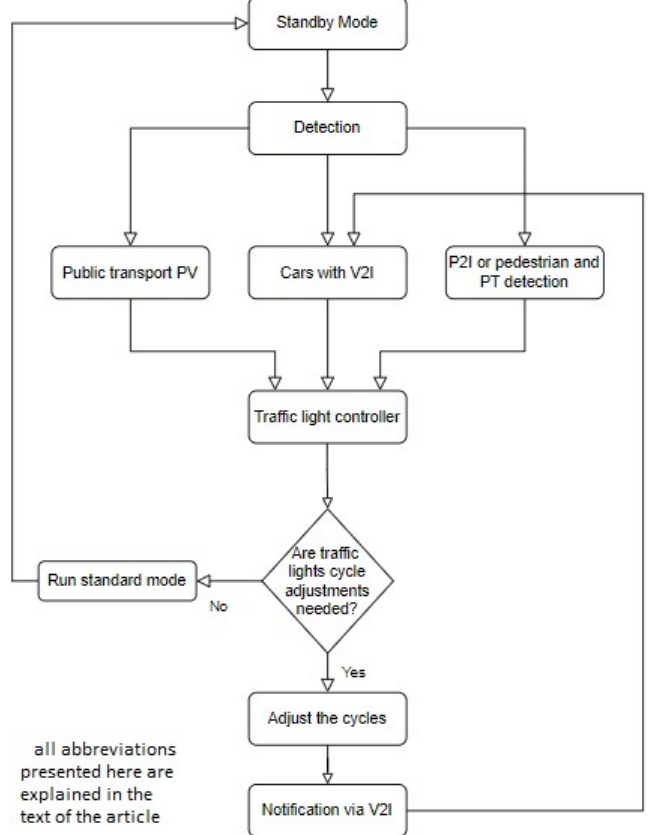
Figure 5. The algorithm for case 2: Communication of vehicles with traffic signals and other users.